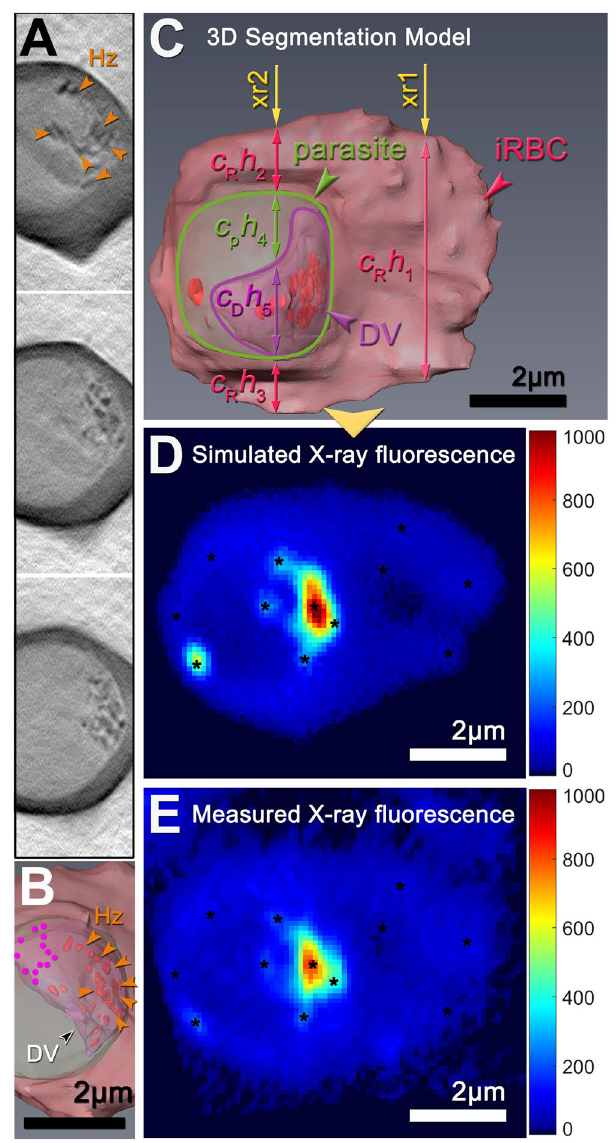
Figure 3. Alignment procedure by 3D segmentation and fluorescence modeling. Shown are selected Z slices from the SXT 3D reconstruction of parasite 8 and its red blood cell ( A ). Each slice in the 3D SXT image is hand segmented to identify the domains of key sub-structures, namely, the red blood cell (magenta), parasite (light green), digestive vacuole (purple) and hemozoin crystals (red) ( B ). The final 3D segmentation can then be used to predict the iron fluorescence obtained from an XRF scan, which produces a 2D projection of the iron levels in the red blood cell and parasite volume. Selected X-ray fluorescence paths (xr1 and xr2) through the specimen are shown ( C ). These traverse different domains of the specimen, which are of different thickness ( h ) and which contain different iron concentrations ( c ). Each domain therefore produces absorption proportional to the product ch , and the sum of these along any path is the predicted absorption in the XRF image. By assigning known iron concentrations to selected compartments, a predicted fluorescent image can therefore be generated ( D , see Supplementary Information for a detailed explanation and calculation). The measured fluorescence image ( E ) can then be morphed onto the simulated fluorescence image, which will account for any random drift of the XRF stage during the measurement. In this way, the morphed XRF image can be overlaid onto the segmented 3D image to back calculate the amount of iron in the hemozoin crystals and the non-crystalline heme elsewhere in the digestive